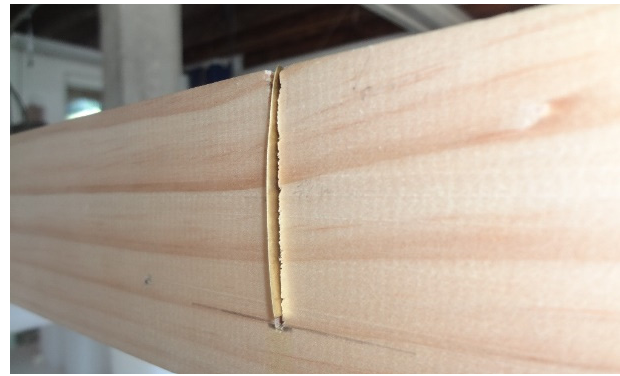
Figure 14. Metal insert cut for S 11 measurements.